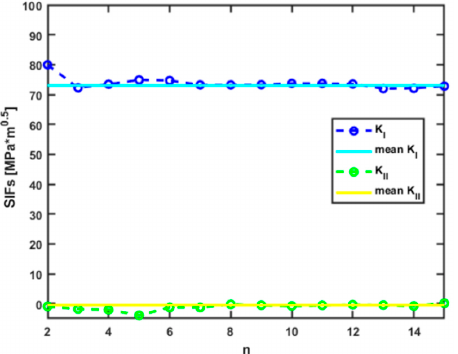
Figure5. Stressintensityfactorsforvaluesof n Figure 5. Stress intensity factors for values of n ranging from 2 to 15 in the case of AM-0-42-42-1 specimen. In Figure 6a comparison between the v-displacements field measured by the DIC and the one fitted by the Williams’ model is shown for various combinations of Mode I and II. As expected, the v-displacements field for Mode I (opening) is symmetric with respect to the crack axis, whereas for mixed mode I-II and Mode II (sliding) the symmetry axis rotates due the shear deformation. In the third column of Figure 6, the difference between the displacement fitted by the theoretical model and